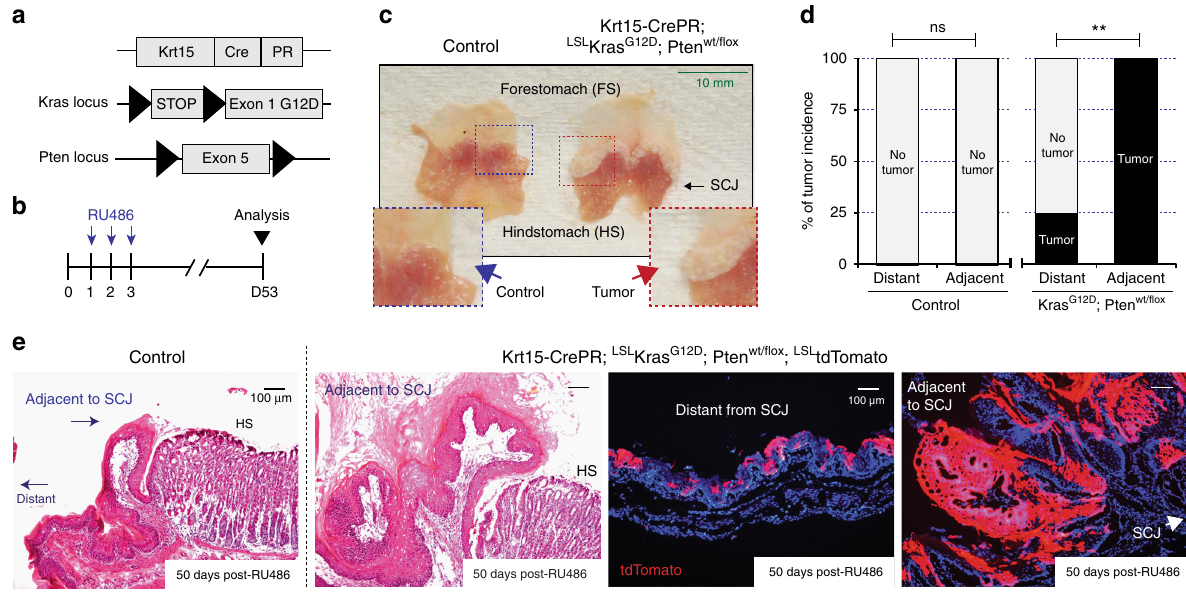
Fig. 3 Higher Ras/Pten-induced tumor incidence at the region adjacent to the squamocolumnar junction (SCJ). a , b Experimental scheme. c Macroscopic phenotype indicates signi fi cant tumor formation throughout the region adjacent to the SCJ. d Tumor incidence from tumor-prone Keratin15 + (Krt15 + ) progenitors. Control, n = 7 animals. Krt15-CrePR; LSL-Kras G12D ; Pten wt/ fl ox , n = 8 animals. Statistical signi fi cance was determined by Fisher ’ s exact test; ns = not signi fi cant, ** p < 0.005. e Histology and tdTomato lineage tracing revealed tumors from tumor-prone Krt15 + progenitors adjacent to the SCJ, while distant progenitors do not show aberrant growth. Scale bars, 100 µ